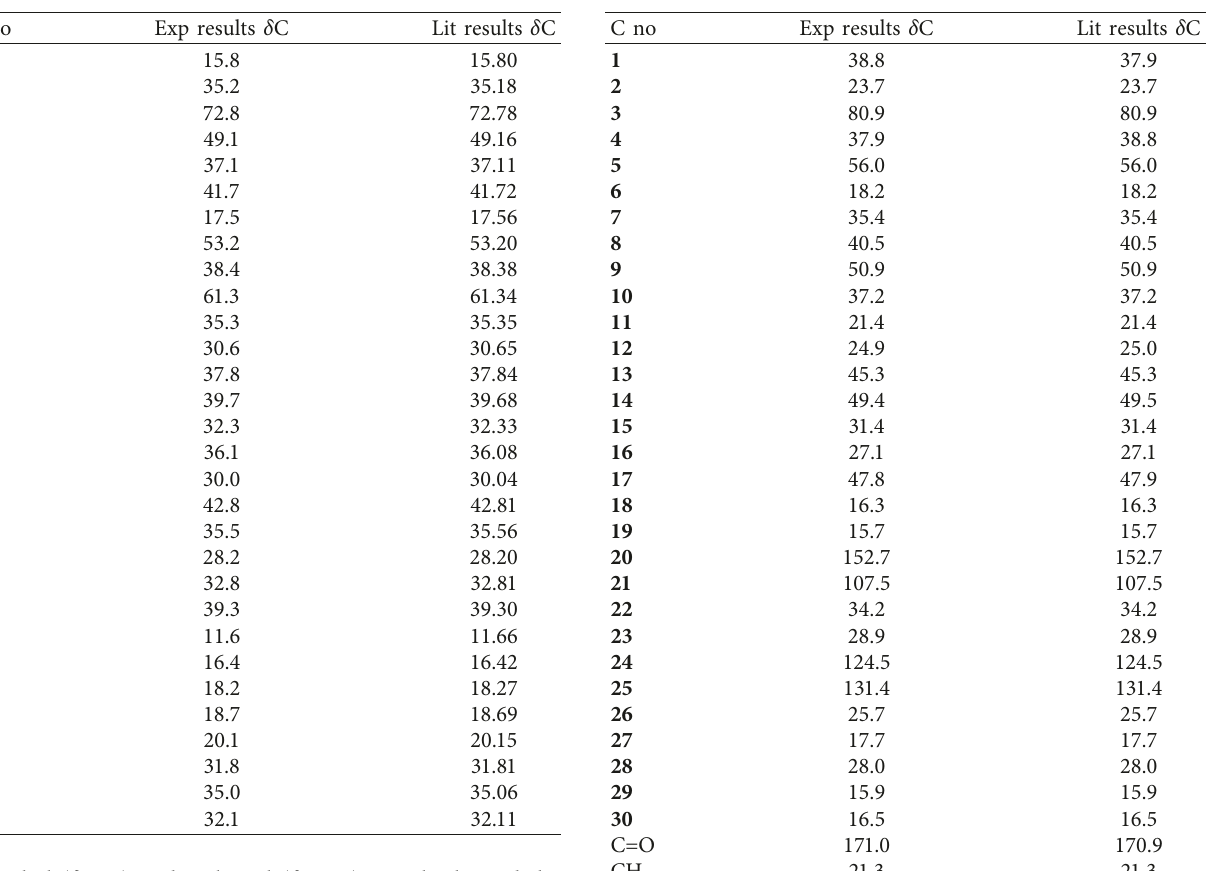
Table 2: 13 C-NMR data of compound 2 and the data reported for Table 1: 13 C-NMR data of compound 1 and the data reported in